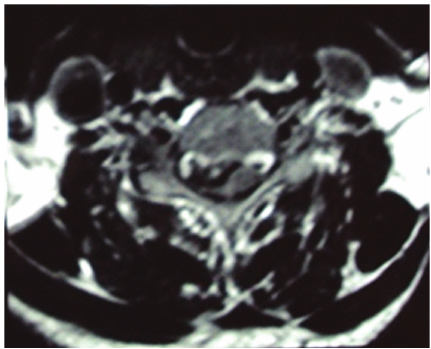
Figure 2: Axial MRI image at C4-C5 level showing compression of right side of cord.